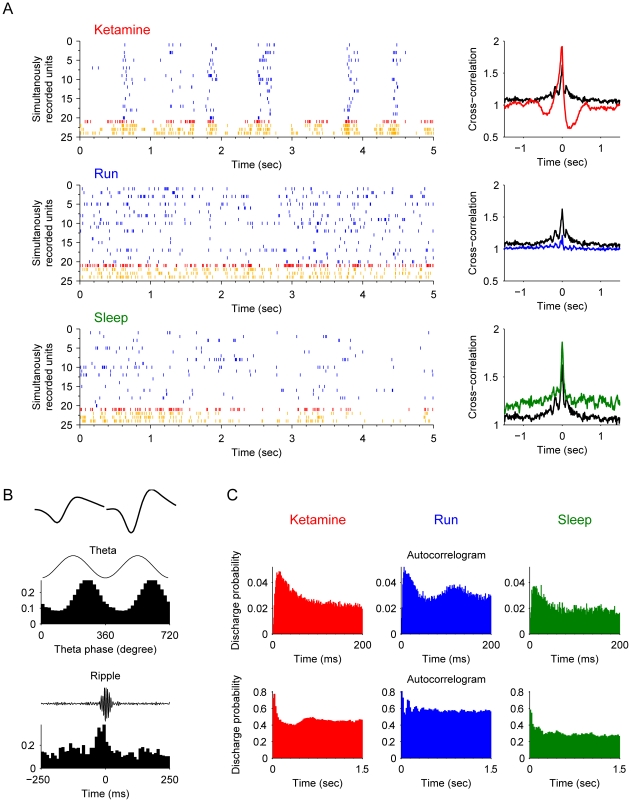
Properties of type-1 interneuron (putative basket cells).(A) Spike rasters of silmultanously recorded pyramidal cells (blue) and basket cells (example plotted here in red, remaining units in orange) after ketamine injection, during running and slow-wave sleep are shown (left panels). The cross-correlation functions of the interneuron and pyramidal cell joint-activities are plotted on the right. The black line is the cross-correlation during the awake rest state. (B) The basic properties of this example basket cell. The most upper left panel shows the average spike waveforms of this unit. The middle left panel illustrates the strongly coupled spike timing of this unit with theta oscillations (p<0.001, Rayleigth's test). The lower left panel shows the significantly elevated firing rate during ripple epochs. (C) Autocorrelograms in different states: after ketamine injection, during running, and during sleep respectively. Autocorrelograms are shown in two time scales for better illustration: 0–200 ms and 0–1.5 sec.